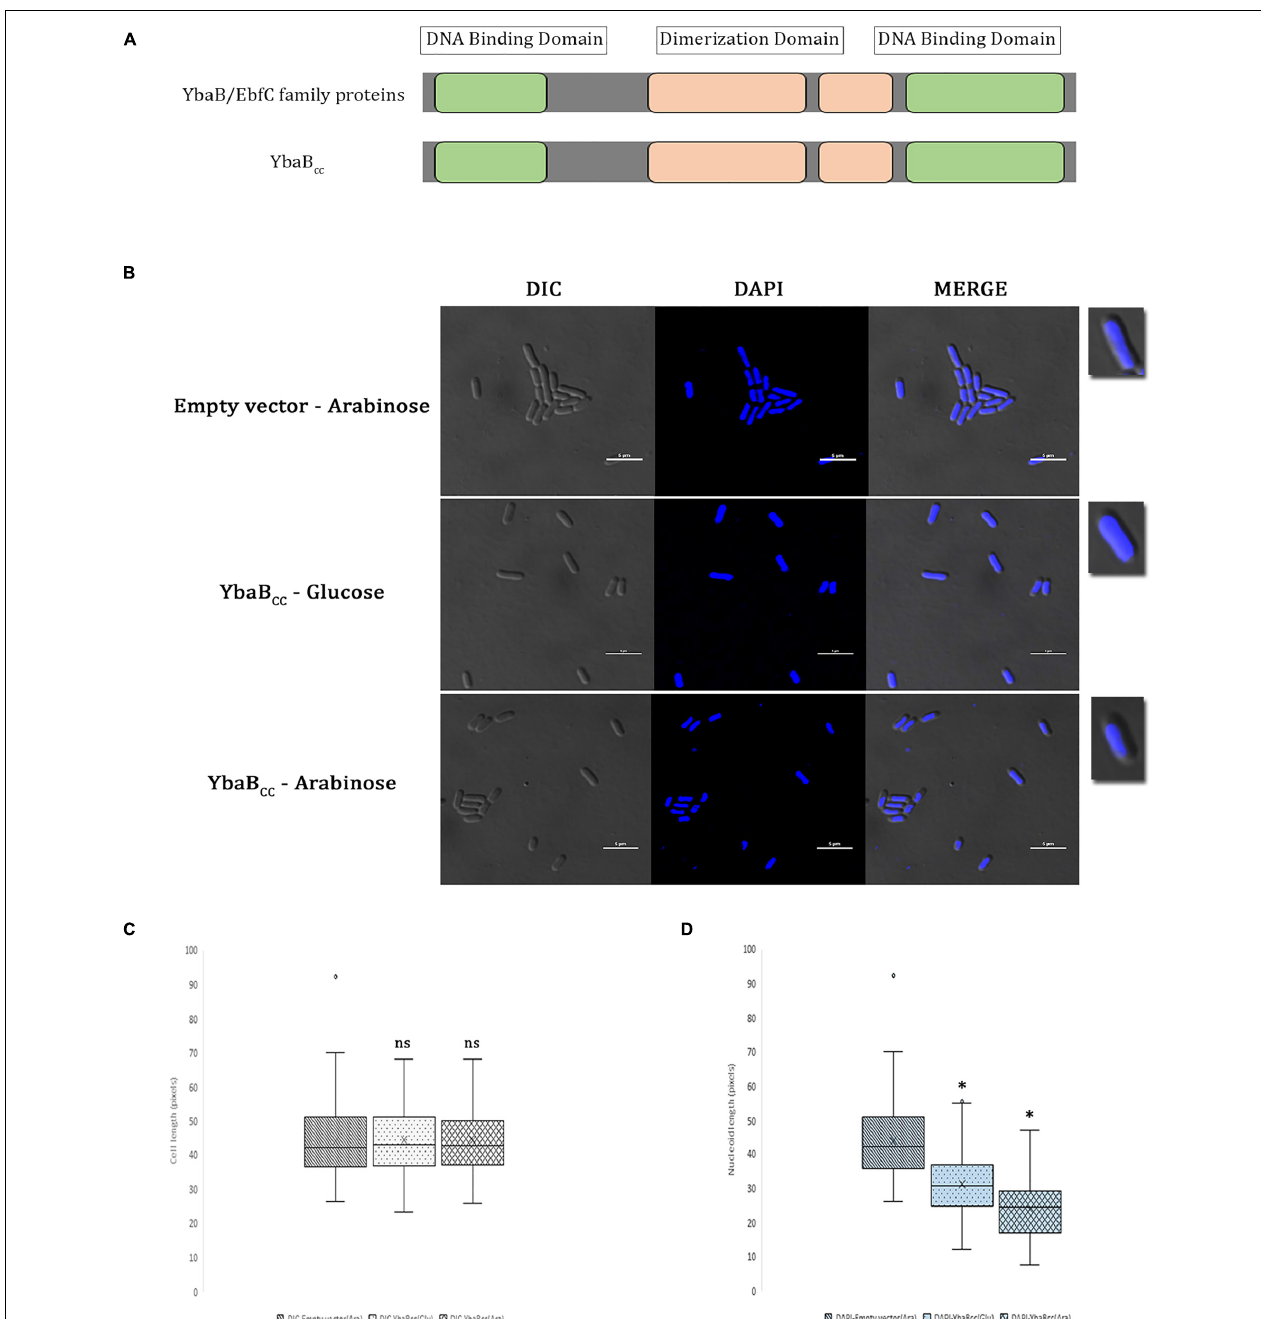
FIGURE 1 | YbaB Cc binds and compacts DNA in E. coli . (A) Schematic presentation of YbaB Cc protein domain organization. YbaB/EbfC family proteins show similarity in domain structures with YbaB Cc . There are two DNA-binding domains present at either terminus of YbaB/EbfC family proteins, which together form a unique tweezer-like structure in order to bind to the target DNA. (B) YbaB Cc overexpression in E. coli cells. YbaB Cc was expressed ectopically from pBAD promoter in RP40 cells. In wild-type E. coli , nucleoid occupies the entire cytoplasmic space, whereas a compacted nucleoid tends to be away from the cell periphery and more toward the center of the bacterial cell. The scale bar represents 5 µ M. (C) Box and whisker plots of mean cell length. Whiskers represent minimum and maximum cell lengths observed in each strain (1 µ M = 32 pixels). Cross (x) represents mean values and horizontal line across boxes represent the median values. Analysis was done using Fiji (ImageJ) software (n, number of cells analyzed = 99 per strain, per condition). (D) Box and whisker plots of mean nucleoid length. Whiskers represent minimum and maximum nucleoid lengths observed in each strain (1 µ M = 32 pixels). Cross (x) represents mean values and horizontal line across boxes represent the median values. Analysis was done using Fiji (ImageJ) software (n, number of cells analyzed = 99 per strain, per condition). (C,D) Same cells were analyzed for measuring cell lengths and nucleoid lengths. YbaB Cc protein bound nucleoid reduces in length as compared to the protein-free nucleoid in non-overexpressing conditions. Box and whisker plots ( n = 99 per strain) were generated for statistical analysis with the whiskers including all data points within 1.5 ∗ IQR. ns = non-significant. ∗ p < 0.0001 by one-way ANOVA compared to the empty vector pBAD (ara) control.